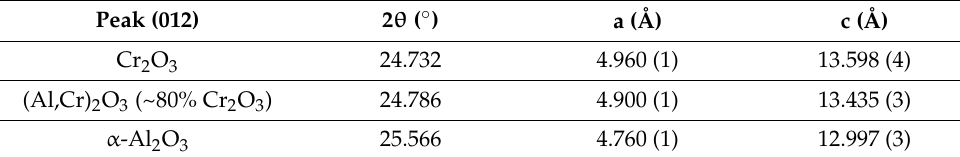
Table 1. The unit cell parameters of (Al,Cr) 2 O 3 and individual